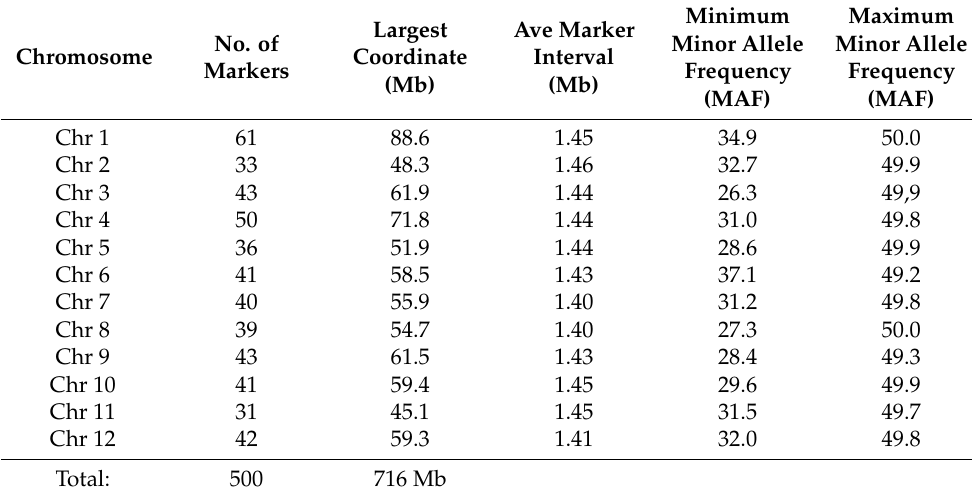
Table 1. The number of SNP markers per potato chromosome for SeqSNP of potato samples with 500 selected SNP markers. The average marker interval and minimum and maximum minor allele frequency (MAF) of selected SNPs (according to [27]) are also presented.